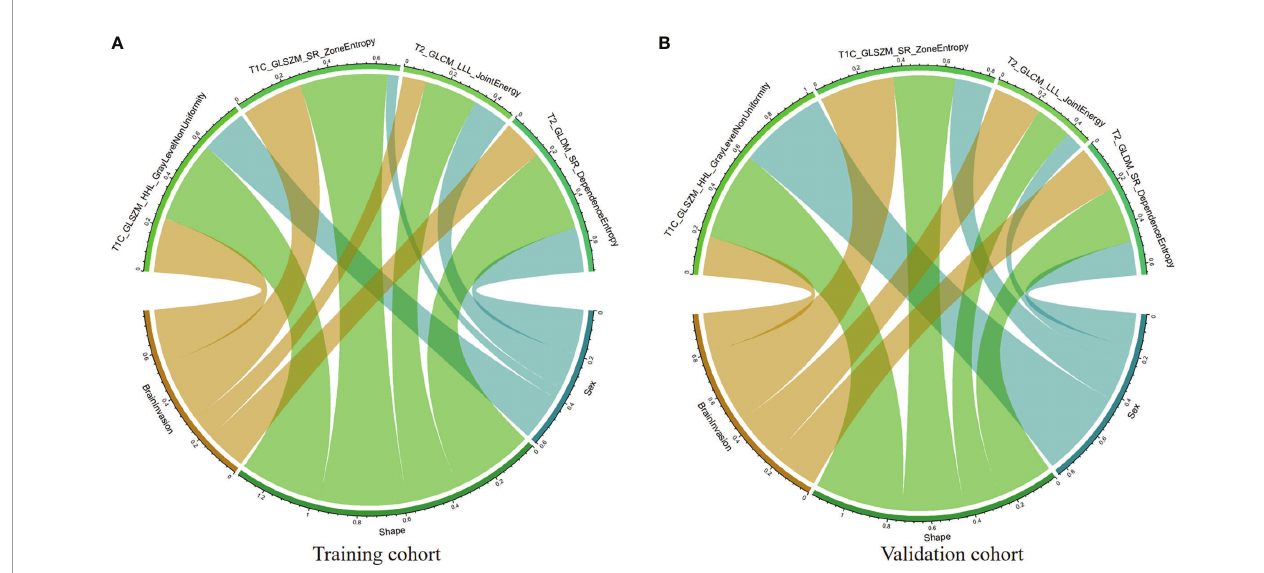
FIGURE 3 | Chord diagram of the correlation between clinicoradiological and selected radiomic features. Correlation analysis of clinicoradiological and selected radiomic features in the training (A) and validation (B) cohorts. The Spearman correlation test con fi rms that each link is signi fi cantly correlated ( P < 0.05). The width of a link represents the strength of the correlation. For example, the T1C_SquareRootGLSZM_squareroot_zoneEntropy feature (gray) is highly correlated with tumor shape in both training and validation cohorts.